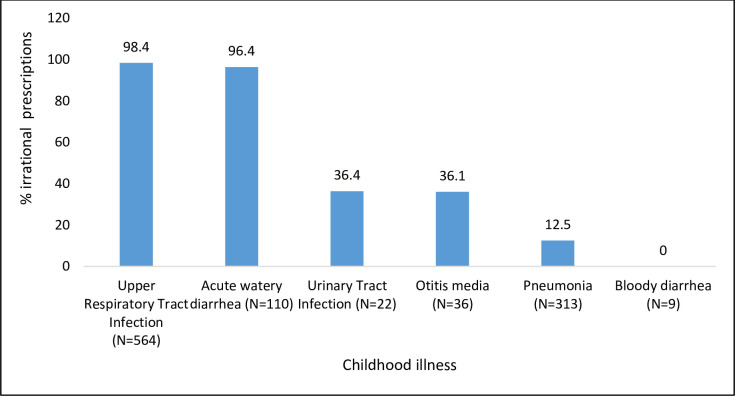
Proportion of irrational antibiotic prescription based on the existing guideline.